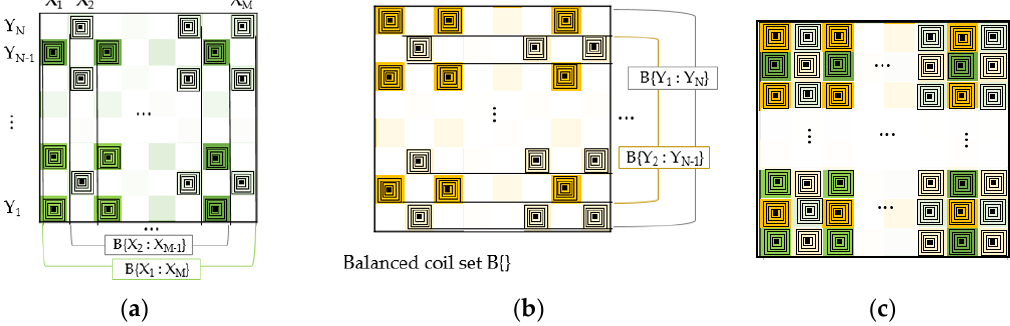
Figure 4. A two-layer balanced coil array architecture. ( a ) Balanced coil array in the first; ( b ) balanced coil array in the second layer; and ( c ) overlapped layers to cover the entire plane.